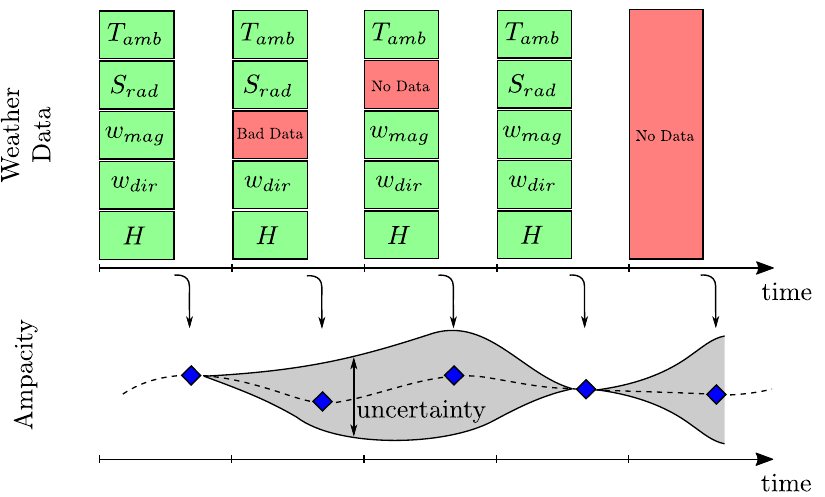
Figure 4. The general relation between the accuracy of input data and ampacity